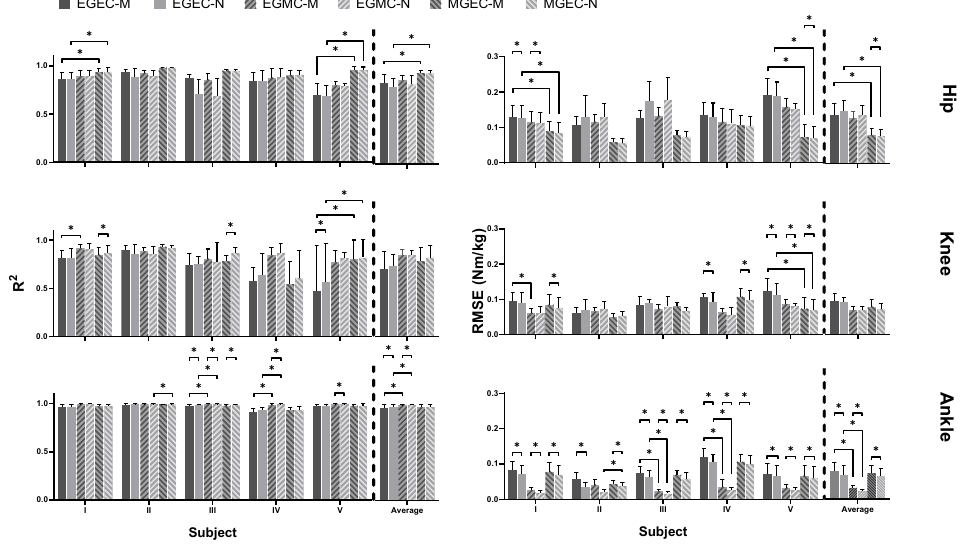
Figure 6. 𝑅 (cid:2870) ( left column ) and RMSE ( right column ) for hip ( top row ), knee ( middle Figure 6. R 2 ( left column ) and RMSE ( right column ) for hip ( top row ), knee ( middle row ) and row ) and ankle ( bottom row ) for each of the following conditions: i) estimated GRF and ankle (bottom row) for each of the following conditions: (i) estimated GRF and COP with muscu- COP with musculoskeletal model (EGEC-M), ii) estimated GRF and COP with neuro- loskeletal model (EGEC-M), (ii) estimated GRF and COP with neuromusculoskeletal model (EGEC- musculoskeletal model (EGEC-N), iii) estimated GRF and measured COP with musculo- N), (iii) estimated GRF and measured COP with musculoskeletal model (EGMC-M), (iv) estimated skeletal model (EGMC-M), iv) estimated GRF and measured COP with neuromusculo- GRF and measured COP with neuromusculoskeletal model (EGMC-N), (v) measured GRF and skeletal model (EGMC-N), v) measured GRF and estimated COP with musculoskeletal estimated COP with musculoskeletal model (MGEC-M), (vi) measured GRF and estimated COP model (MGEC-M), vi) measured GRF and estimated COP with neuromusculoskeletal with neuromusculoskeletal model (MGEC-N). Asterisk indicates statistically significant difference model (MGEC-N). Asterisk indicates statistically significant difference ( p < 0.05). ( p < 0.05). Table 4. R 2 of joint torques averaged across all the trials and subjects for all the conditions: Table 4. 𝑅 (cid:2870) of joint torques averaged across all the trials and subjects for all the condi- (i) estimated GRF and COP with musculoskeletal model (EGEC-M), (ii) estimated GRF and COP tions: i) estimated GRF and COP with musculoskeletal model (EGEC-M), ii) estimated with neuromusculoskeletal model (EGEC-N), (iii) estimated GRF and measured COP with muscu- GRF and COP with neuromusculoskeletal model (EGEC-N), iii) estimated GRF and loskeletal model (EGMC-M), (iv) estimated GRF and measured COP with neuromusculoskeletal measured COP with musculoskeletal model (EGMC-M), iv) estimated GRF and measured model (EGMC-N), (v) measured GRF and estimated COP with musculoskeletal model (MGEC-M), COP with neuromusculoskeletal model (EGMC-N), v) measured GRF and estimated COP (vi) measured GRF and estimated COP with neuromusculoskeletal model (MGEC-N). with musculoskeletal model (MGEC-M), vi) measured GRF and estimated COP with neuromusculoskeletal model (MGEC-N). Joint Condition Hip Knee Ankle Condition EGEC-M 0.84 ±